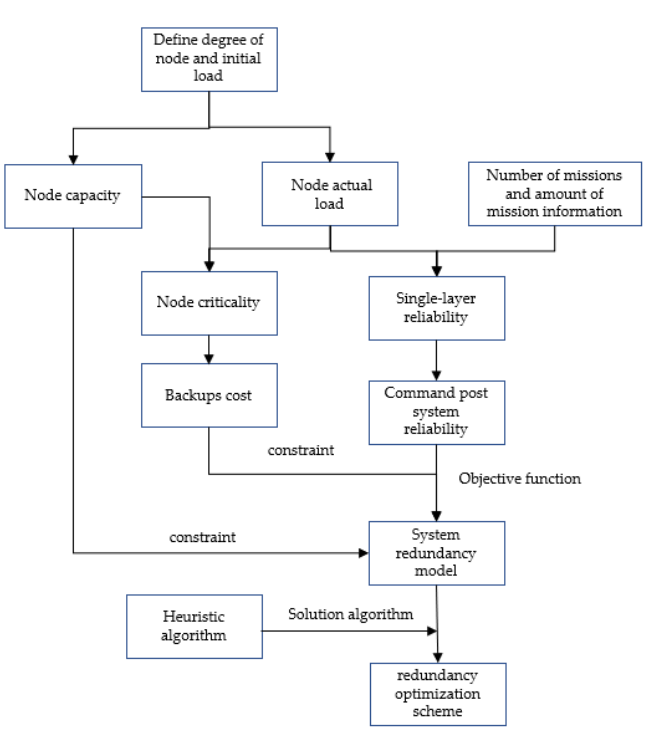
Figure 1. Content flowchart.